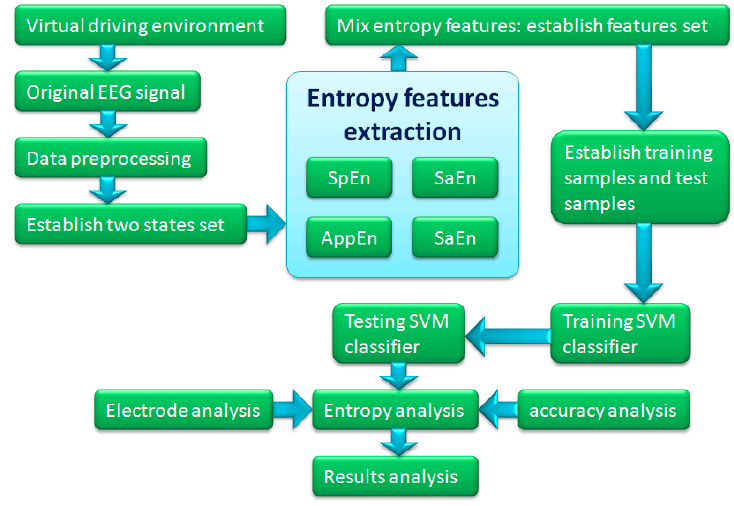
Figure 1. A flowchart to show the operation steps. EEG: electroencephalography; SVM: support vector machine.